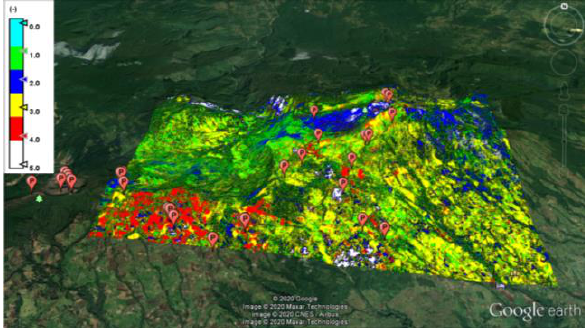
Figure 8. Validation points in the Turrialba volcano for 2017 and 2018.